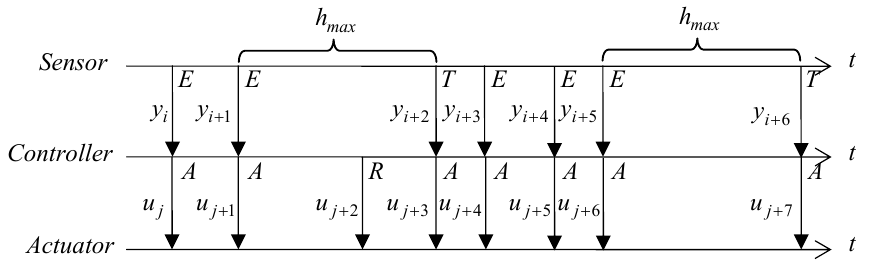
Figure 3. Exchange of information between sensor, controller, and actuator in the event-based approach. The E represents when the error-based condition of the sensor becomes true and the T represents when the sending is forced by a time-out. An A represents a new arrival, and R a change of the set-point value.